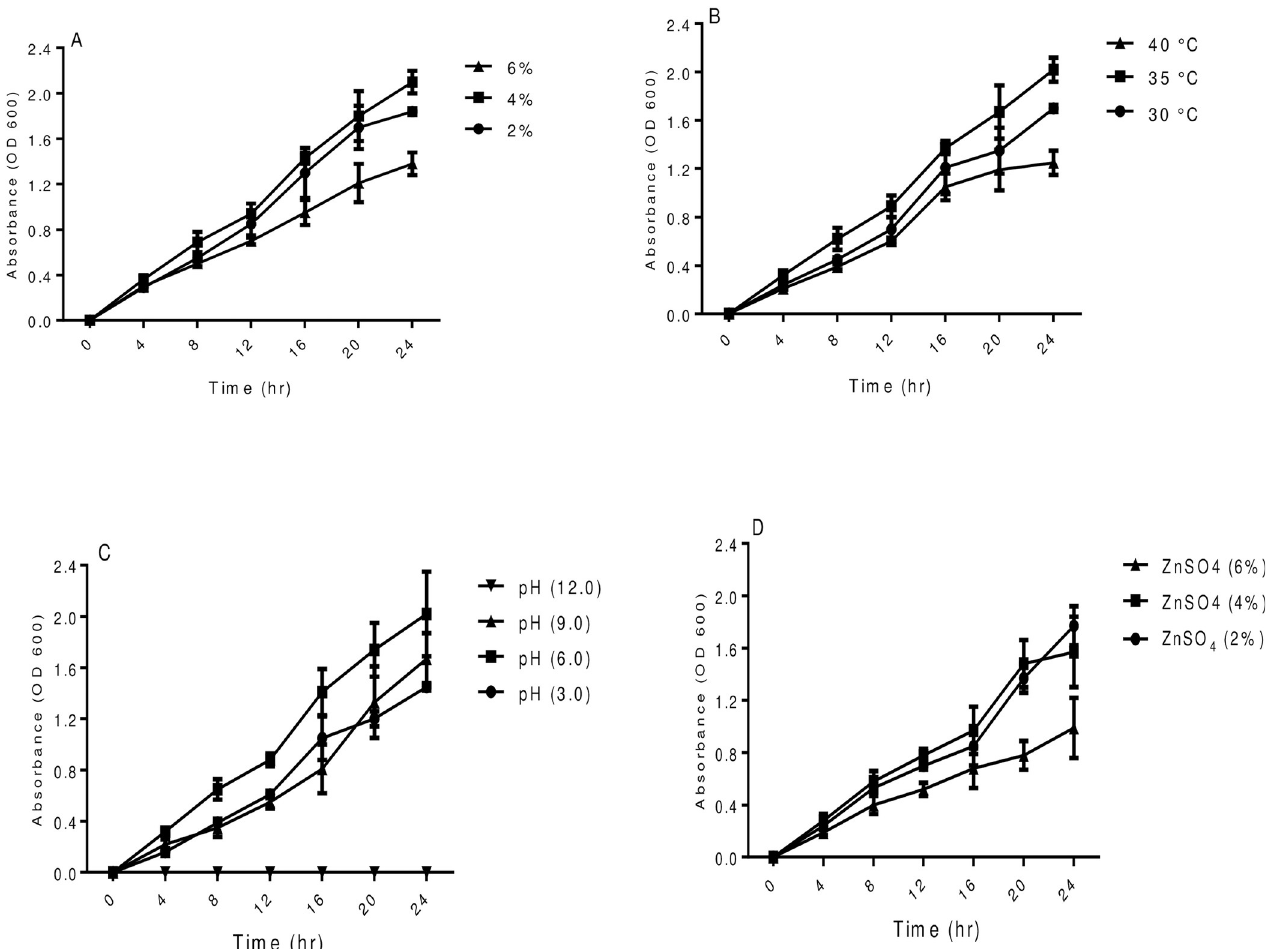
Fig 3. Growth curve of ZNP-4 under different conditions (A) varying concentration of NaCl (B) different temperature (C) different pH (D) ZnSO 4 concentrations. Each value represent the mean of three replicates ± SD (n = 3).